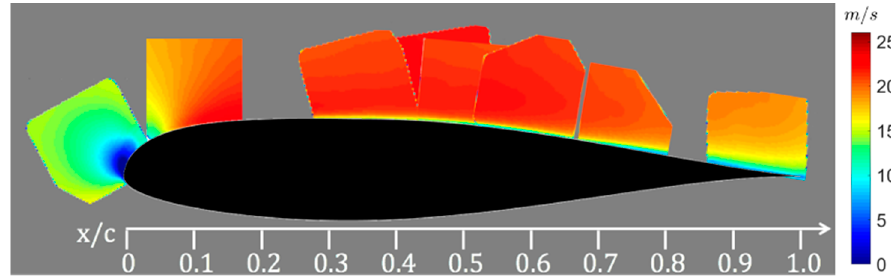
Figure 5. Particle image velocimetry (PIV) near-surface planes on airfoil suction side. Colors are visualizations of mean velocity magnitude.